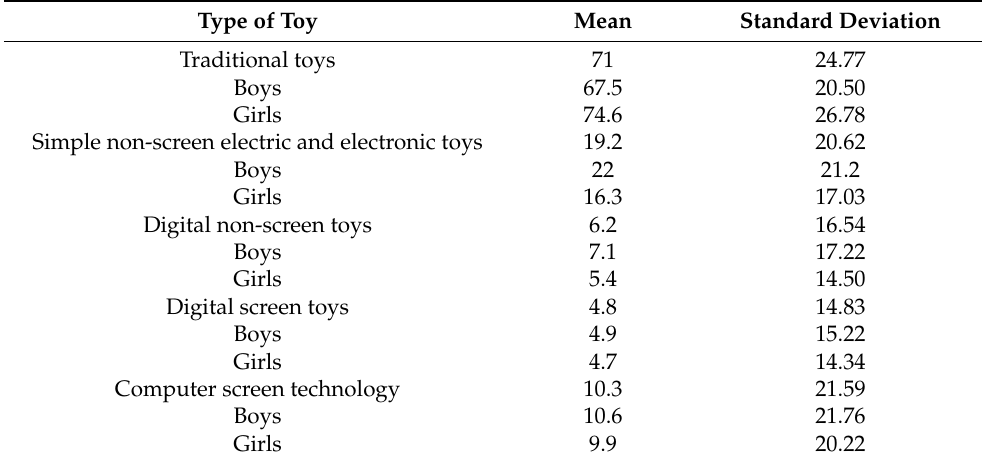
Table 1. Toy ownership—analogue vs.